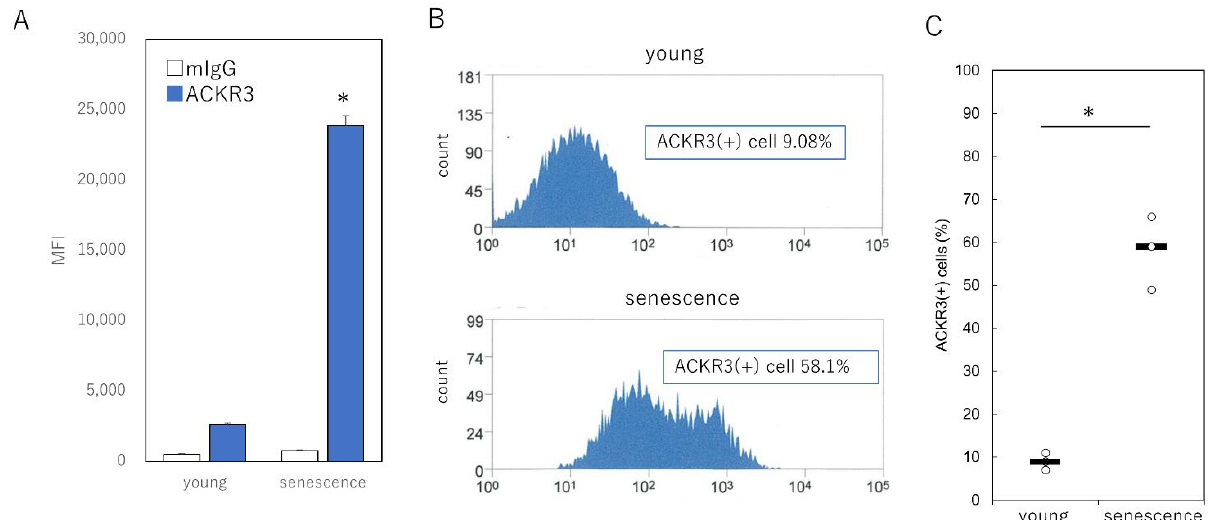
Figure 3. Sorting of senescent cells using an anti-ACKR3 antibody. ( A ) Sorting of ACKR3-positive cells in proliferating and senescent cells. ( B ) Histograms from flow cytometry analysis representing control IgG and anti-ACKR3 antibodies. ( C ) Comparison of the number of ACKR3-positive cells. Each data point represents a young ( n = 3 total) or senescence ( n = 3 total) subject; horizontal lines indicate the mean values. * p < 0.05. All experiments were performed in triplicate. MFI: mean fluorescence intensity.